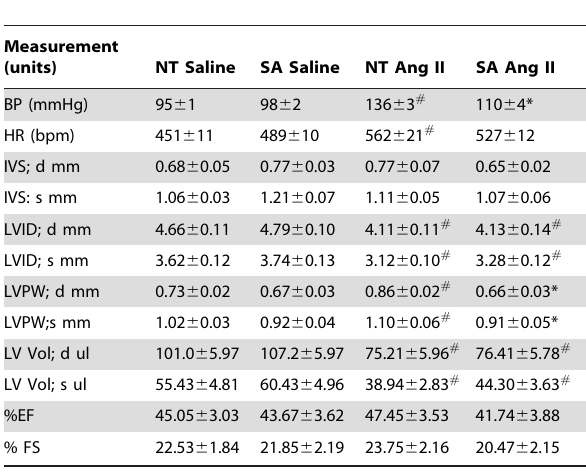
Table 1. Cardiac hemodynamic parameters for NT and SA